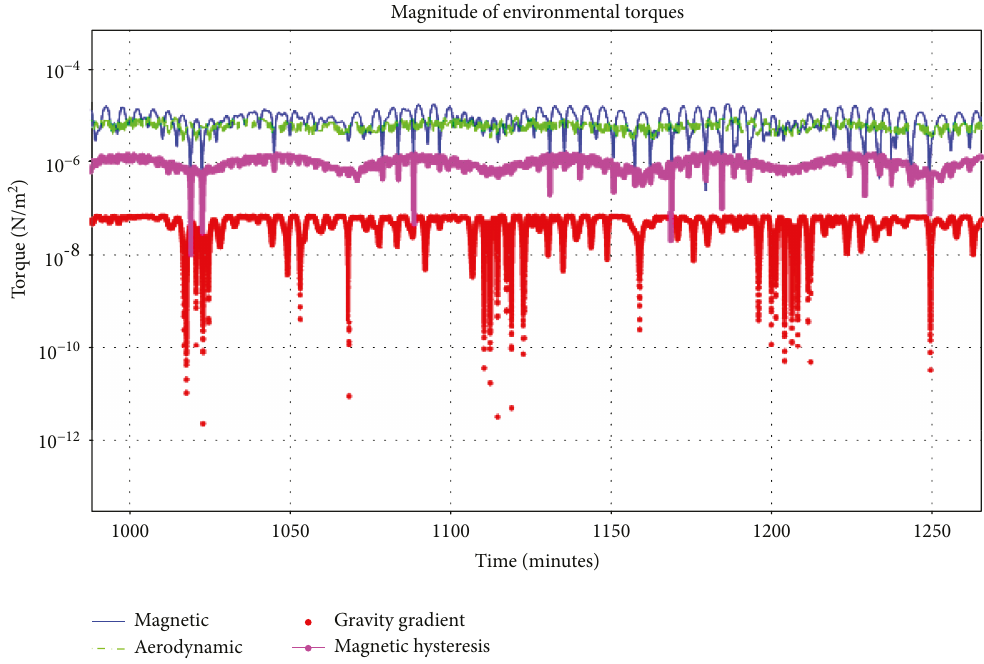
Figure 9: Simulated 3U CubeSat at ISS orbit, including aerodynamic torques. This fi gure shows the magnitude of environmental torques during 250 minutes in the steady state. Aerodynamic torque is of the same order as the magnetic control torque, which results in degraded tracking.